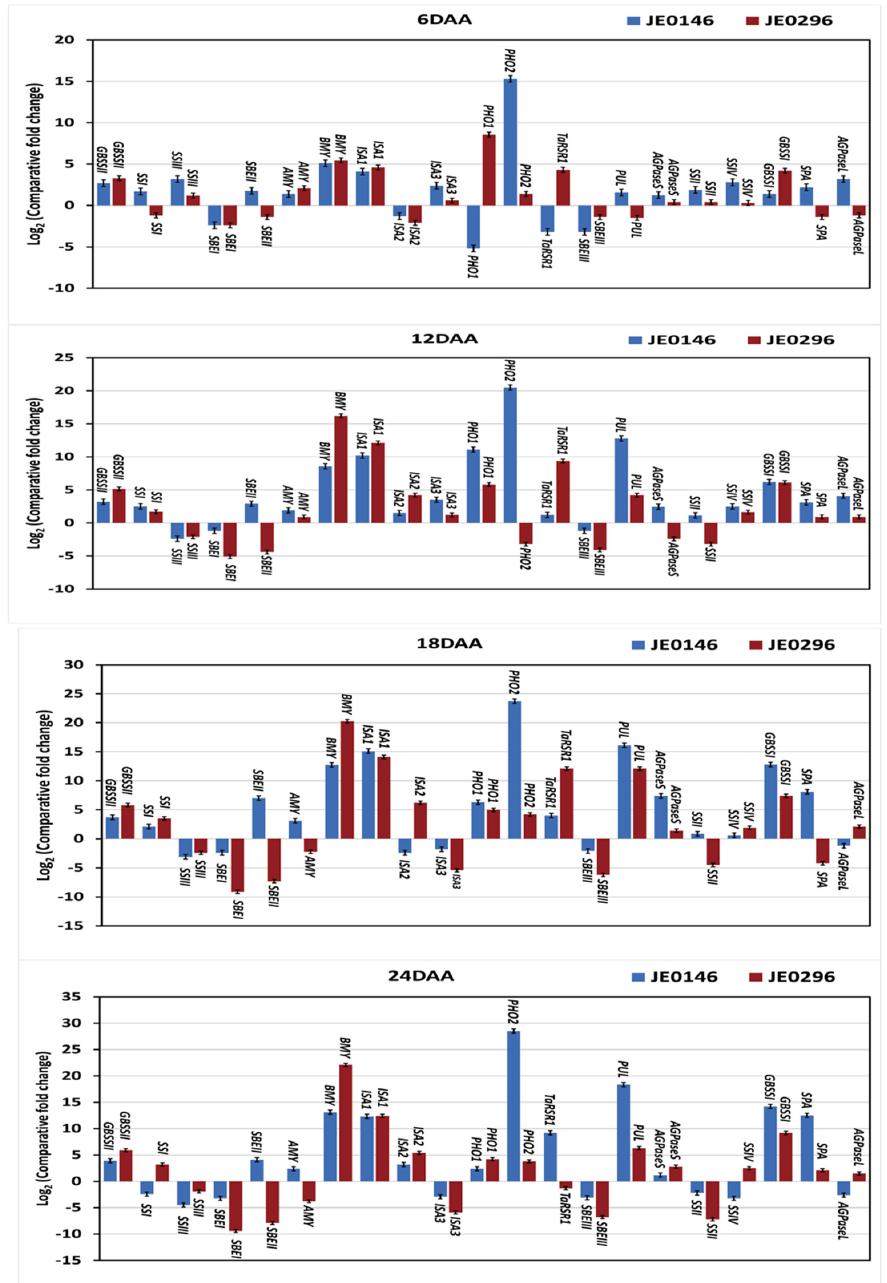
Figure 5. Real-time quantitative expression data (Log2 of fold change) of 21 starch metabolic genes during the seed development in the high resistant starch mutant lines, ‘JE0146 and JE0296’, in comparison to the parent variety, ‘J411’. The seed development stages were 6, 12 18, and 24 days after anthesis (DAA). All the data are represented as mean ± SD from two biological and three technical replicates.